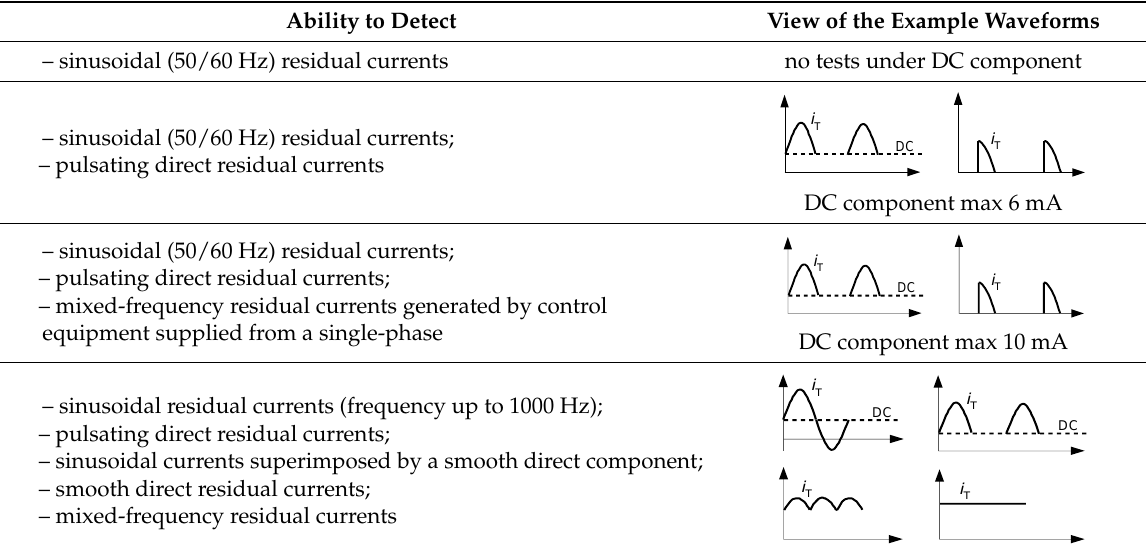
Table 1. Types of RCDs and sample normative waveforms i T with DC component (or direct current of low pulsation) for RCDs testing.